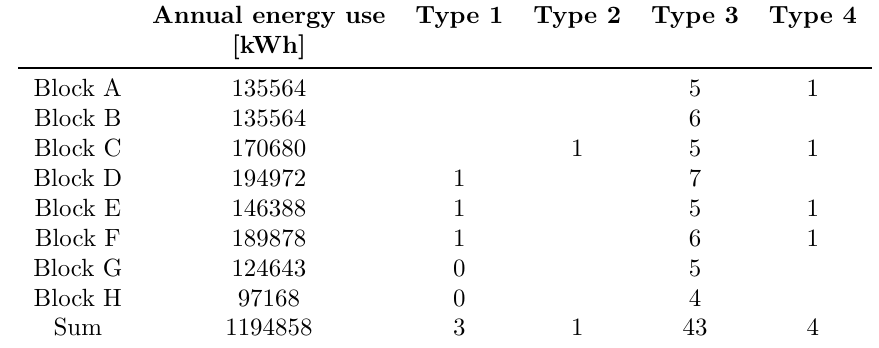
Table 5. Energy use.